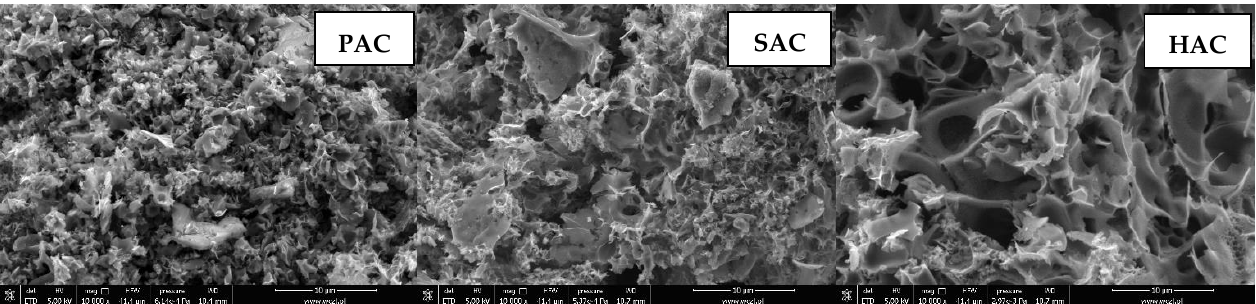
Figure 3. SEM images of PAC, SAC and HAC activated biocarbons.